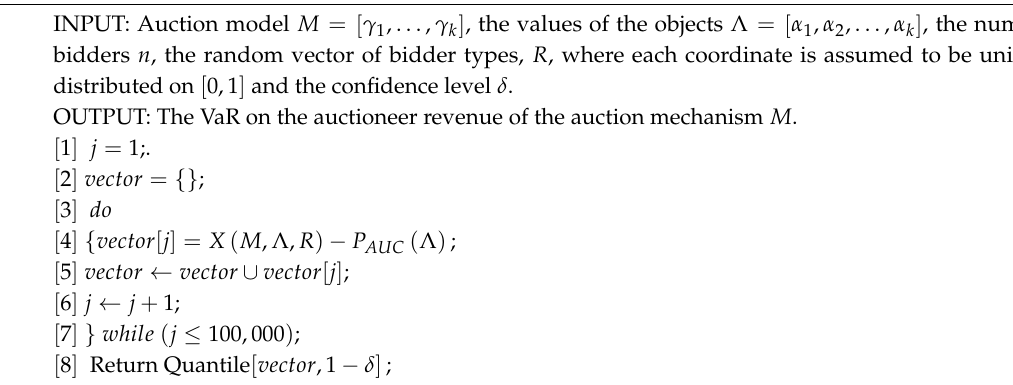
Algorithm 1: Algorithm for computing